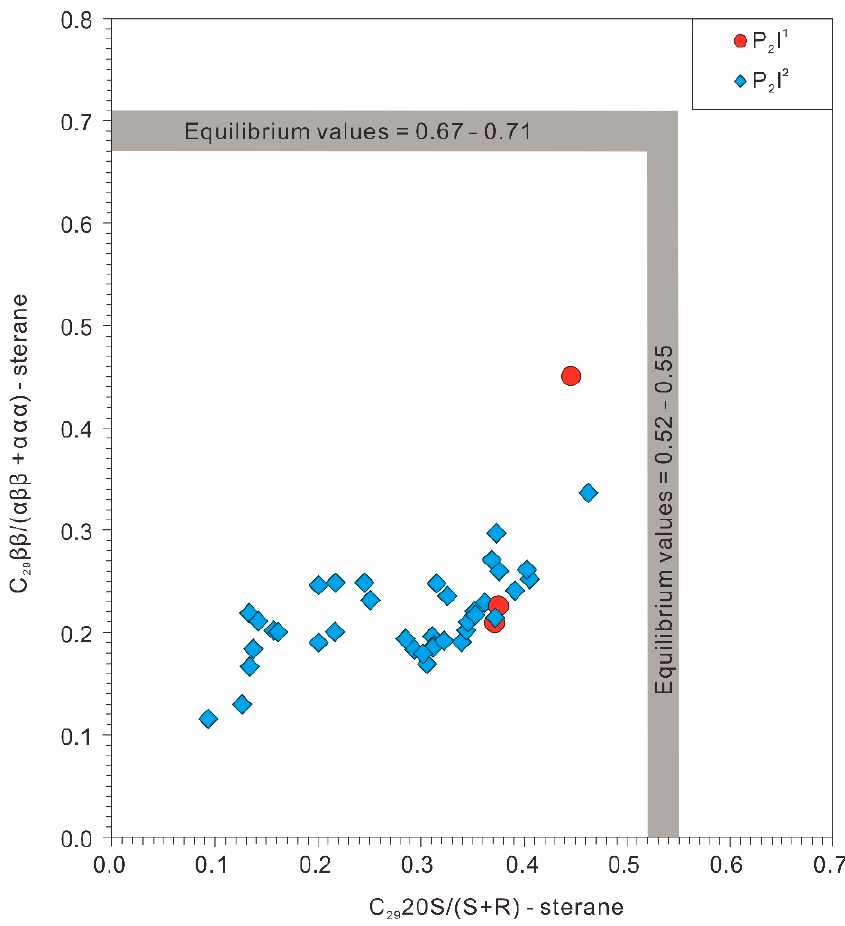
Figure 8. Use of sterane isomer maturity parameters to determine the organic matter maturity of the P 2 l source rocks in the Jimsar Depression.